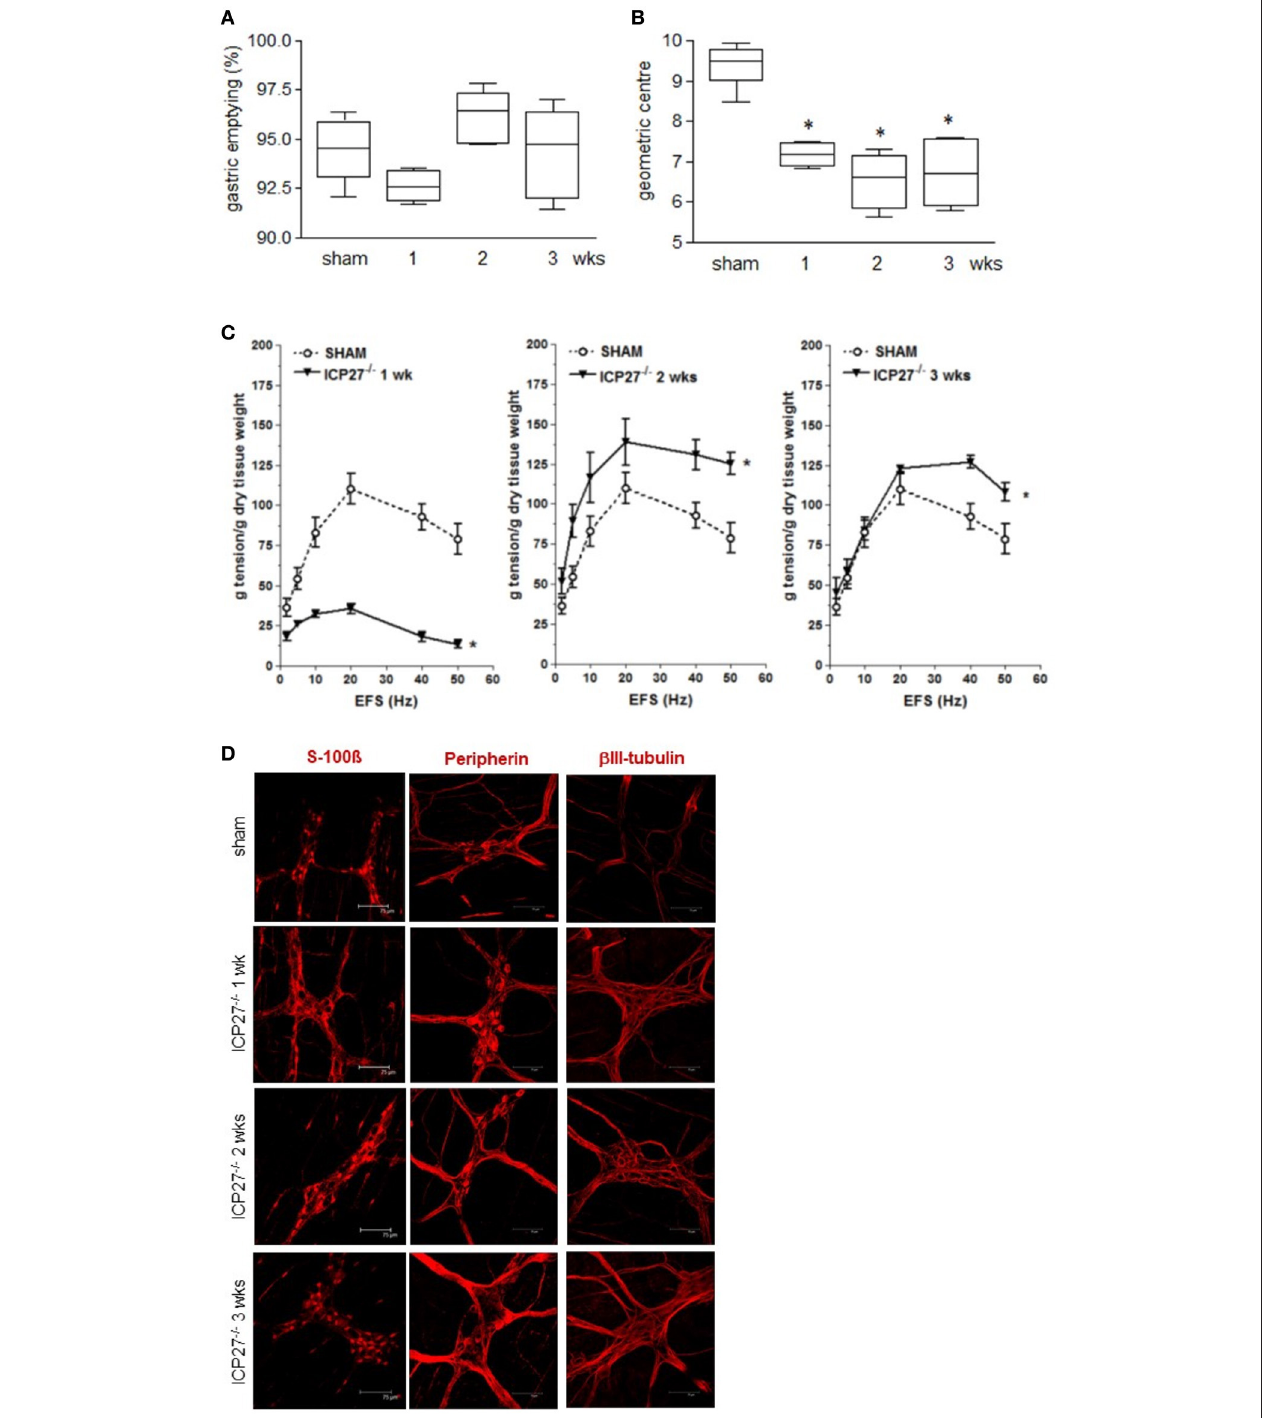
FIGURE 4 | Persistence of gastrointestinal alterations in mice infected with HSV-1 replication-defective strain (A) Mice were injected IG with HSV-1 IGR20 1 ICP27gJHE (ICP27 − / − ) replication-defective strain. Mice received non-absorbable FITC-labeled dextran 1, 2, and 3 weeks post-IG inocula. Sixty minutes later mice were sacrificed, and gastric emptying was calculated as the percentage of probe retained into the stomach compared with the total amount of fluorescence in the gastrointestinal tract. (B) Distribution of FITC-labeled dextran was determined in the intestine. Intestinal transit was reported as the geometric center of distribution of the fluorescent probe throughout the ileum. (C) EFS-elicited contractions in segments of ileum of sham and IG HSV-1 ICP27 − / − infected mice. Data are represented as mean ± SEM. n = 6 mice per group. *Denotes P < 0.01 compared to sham infected mice. (D) Immunofluorescence analysis for S-100 β , peripherin, and β III-tubulin on whole mount preparations of ileum of HSV-1 ICP27 − / − infected mice. Scale bars: 75 µ m. Representative images of three separate experiments.